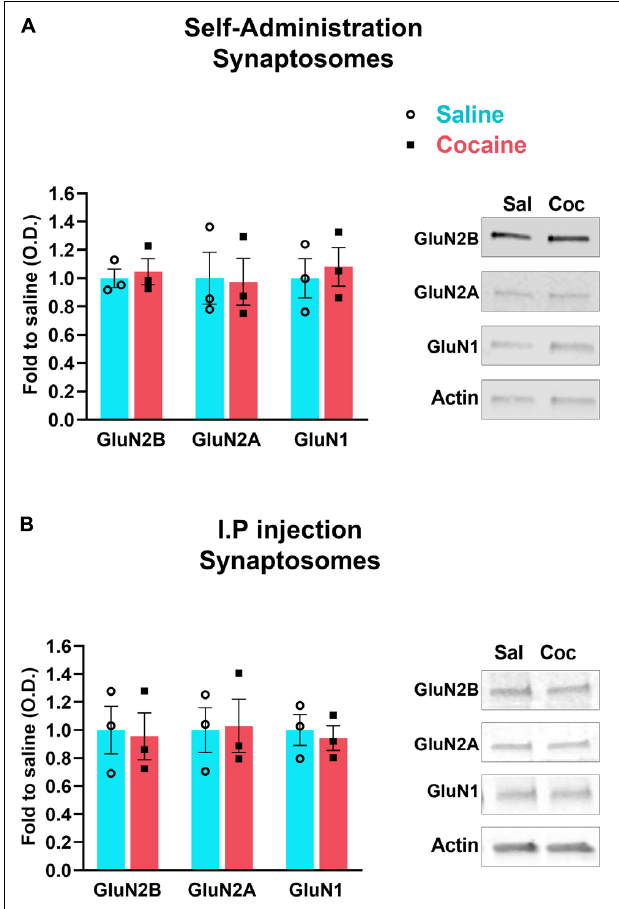
FIGURE 2 | Accumbens shell was dissected 24 h after the last self-administration session (A) or i.p. daily injection of cocaine (B) . Synaptosomal fraction was isolated and analyzed by western blot to detect the indicated proteins. N = 3 samples/group, 4 mice/sample, total of 12 animals/group. Data are represented as mean ± SEM (minimum of 3 independent